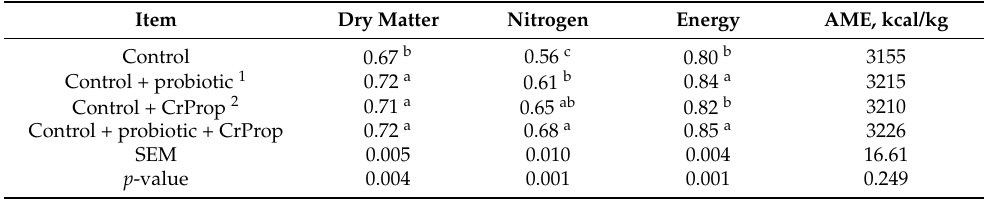
Table 5. Coefficient of total tract metabolizability and apparent metabolizable energy (AME) of layer breeders fed diets supplemented with the probiotic and chromium propionate at 70 weeks of